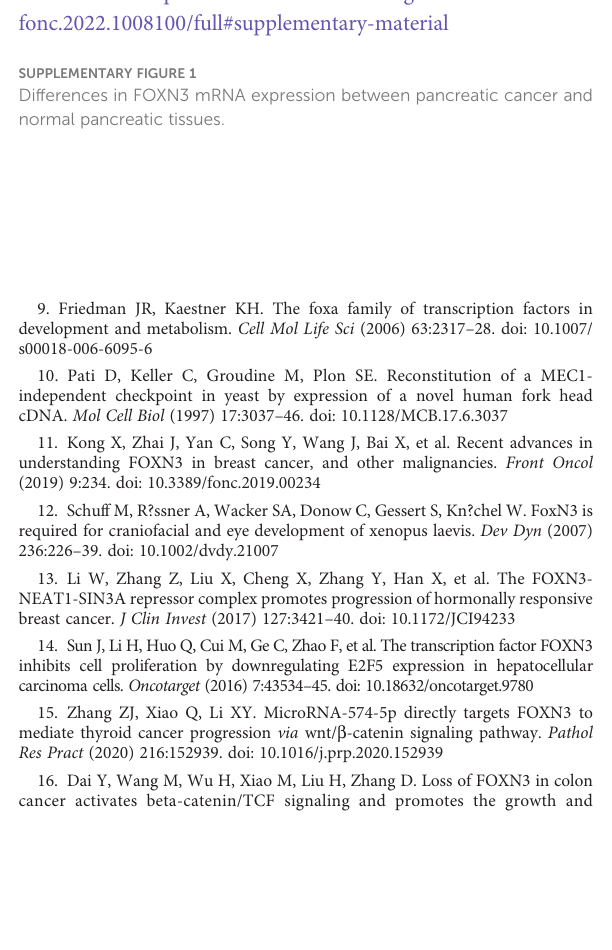
SUPPLEMENTARY FIGURE 1 Differences in FOXN3 mRNA expression between pancreatic cancer and normal pancreatic